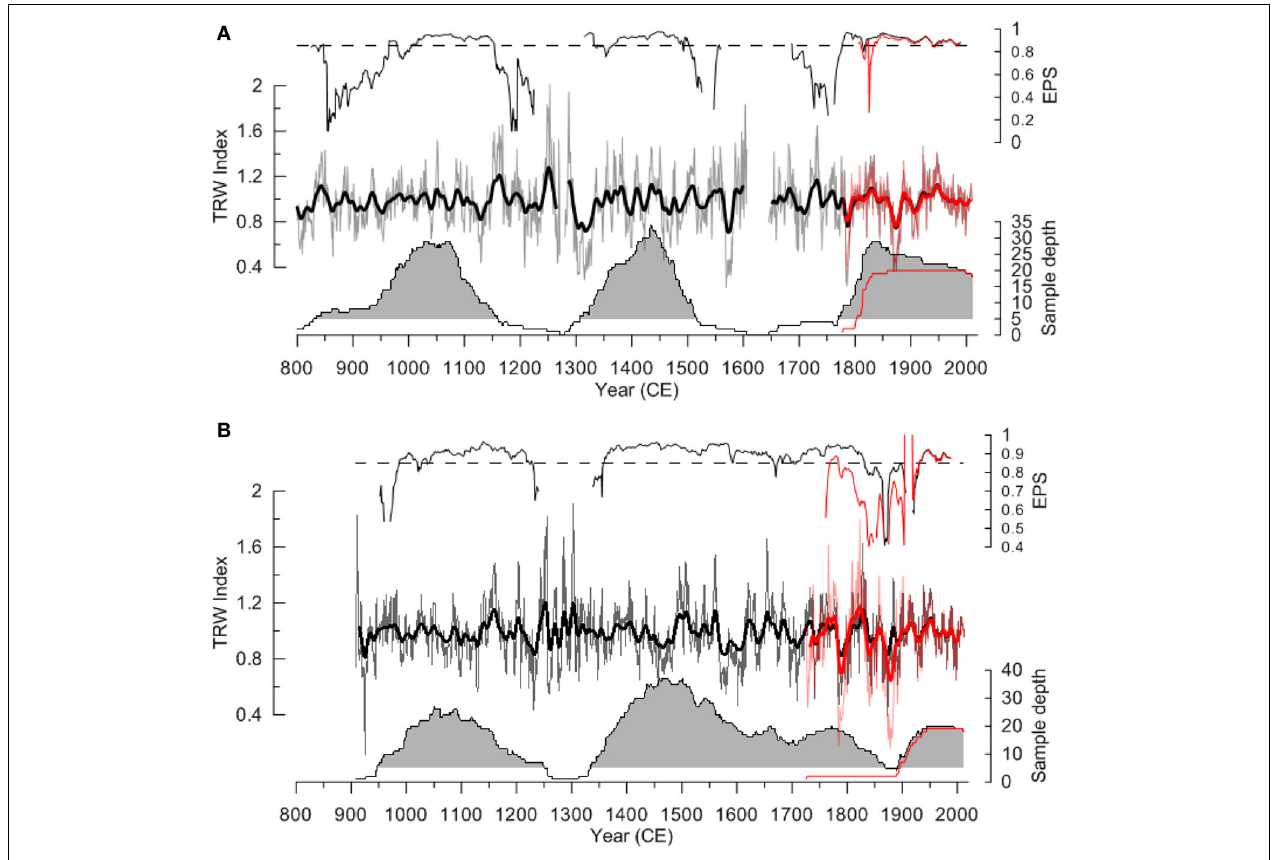
FIGURE 3 | Tree-ring width indices, sample replication, and EPS statistics for the (A) tree-line (drywood) chronology, and (B) the subfossil (lake-shore) chronology. Thick line shows smoothed chronologies with a 15-year low-pass Gaussian-weighted filter. Red curves show the chronology